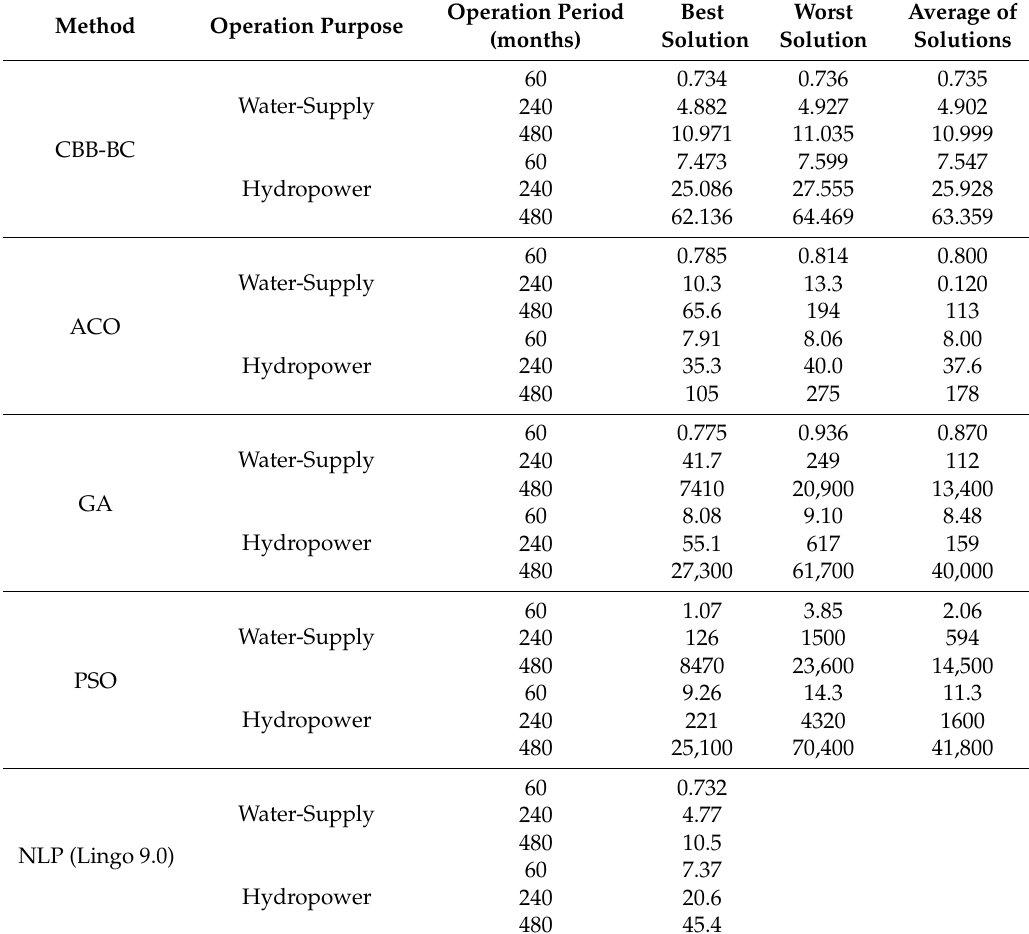
Table 7. Results obtained by alternative approaches for the optimal operation of “Dez” reservoir, disregarding evaporation losses